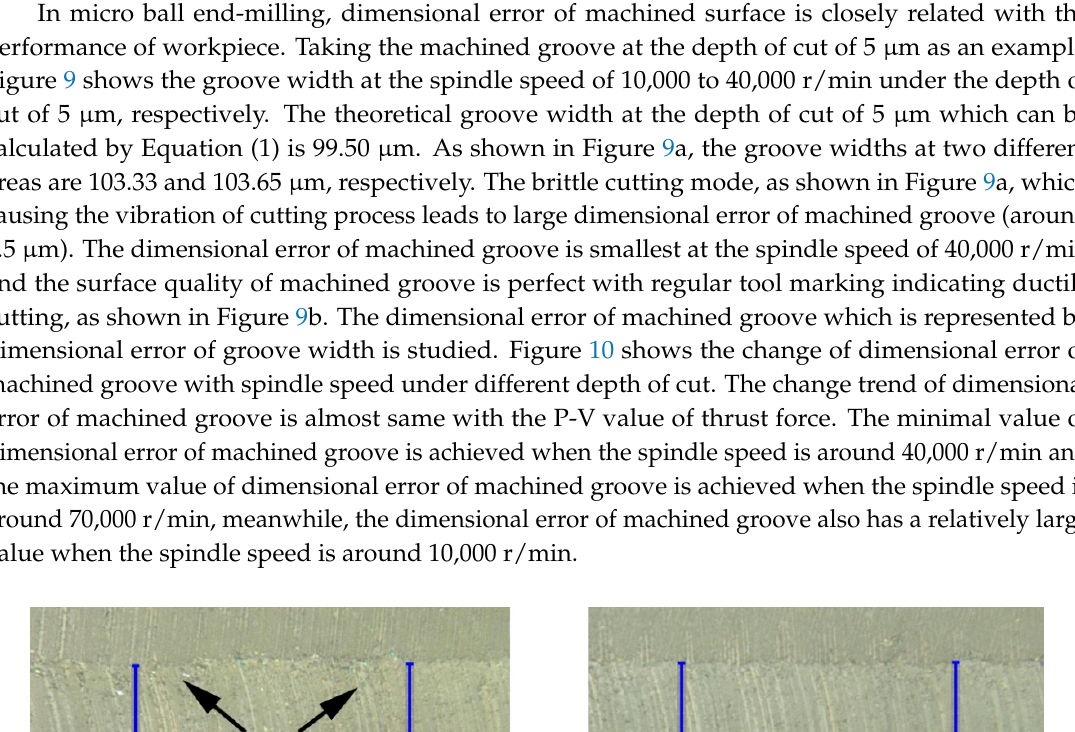
Figure 8. The change of P-V value of thrust force with spindle speed under different depth of cut.